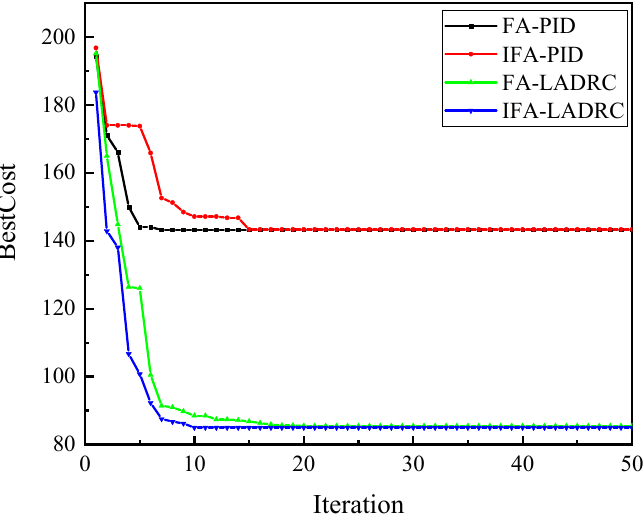
Figure 6. Convergence curve. Table 3. Optimization parameters under PID controller and error integration index.